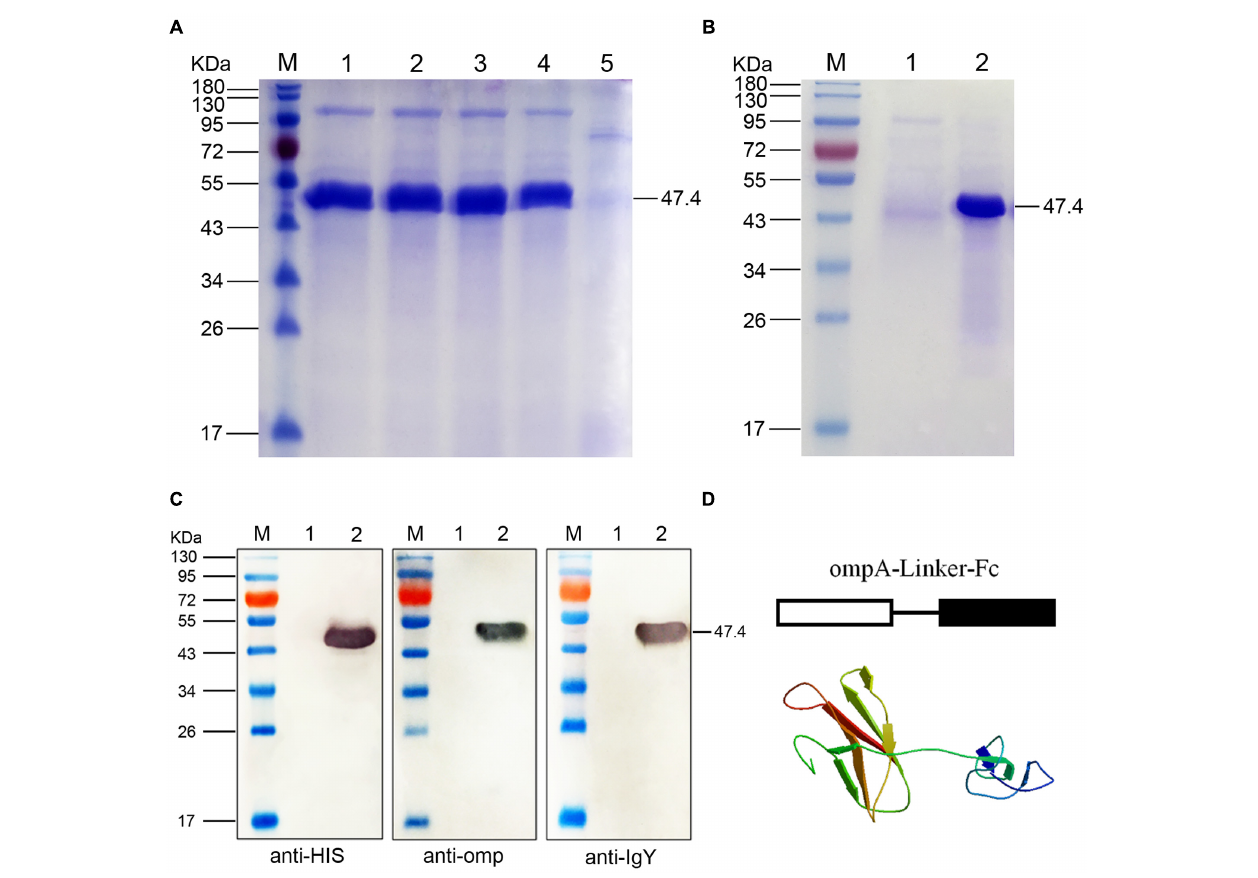
FIGURE 1 | SDS-PAGE and Western blot analyses of the fused ompA–Fc expressed in Pichia pastoris . (A) SDS-PAGE identification of the fusion ompA–Fc at different induction times. M, Page ruler pre-stained protein ladder; lanes 1–4, culture supernatant of P. pastoris transformed with the recombinant pPIC9-ompA–Fc plasmid after 96, 72, 48, and 24 h of methanol induction; lane 5, culture supernatant of P. pastoris transformed with blank pPIC9 vector (negative control). (B) Purification of the fused ompA–Fc. M, Page ruler pre-stained protein ladder; lane 1, purified ompA–Fc; lane 2, culture supernatant after column chromatography. (C) Western blot analyses of the fused ompA–Fc with the anti-His tag antibody, mouse anti-omp polyclonal antibody, and the rabbit anti-chicken IgG (HRP). M, protein molecular size page ruler; lane 1, culture supernatant of P. pastoris transformed with blank pPIC9 vector (negative control); lane 2, culture supernatant of P. pastoris transformed with the recombinant pPIC9-ompA–Fc plasmid at 96 h post induction. (D) Schematic and 3D structure of the fused ompA–Fc.